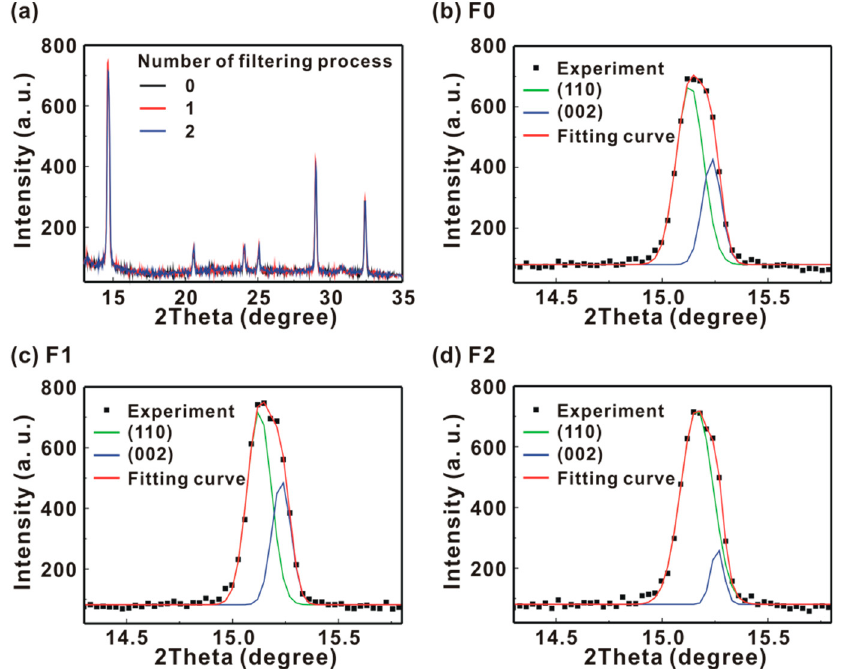
Figure 6. ( a ) X-ray diffraction patterns of the MAPbI 3 /P3CT-Na/ITO/glass samples. Main diffraction peaks of the MAPbI 3 thin films at (110) and (002): ( b ) without filtering process; ( c ) single-filtering process; ( d ) double-filtering process.